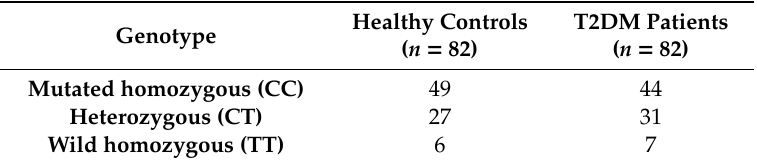
Figure 1. Electrophoresis of PCR product of VDR exon 2 region which contains the FokI polymorphism on 2.5% agarose gel. Lane M: DNA marker (100 bp); lane-ve: negative control: lane 1–12, samples with 265 bp bands. Table 2. Frequencies of different FokI polymorphism genotypes for healthy controls and Type 2 diabetes mellitus (T2DM) patients.